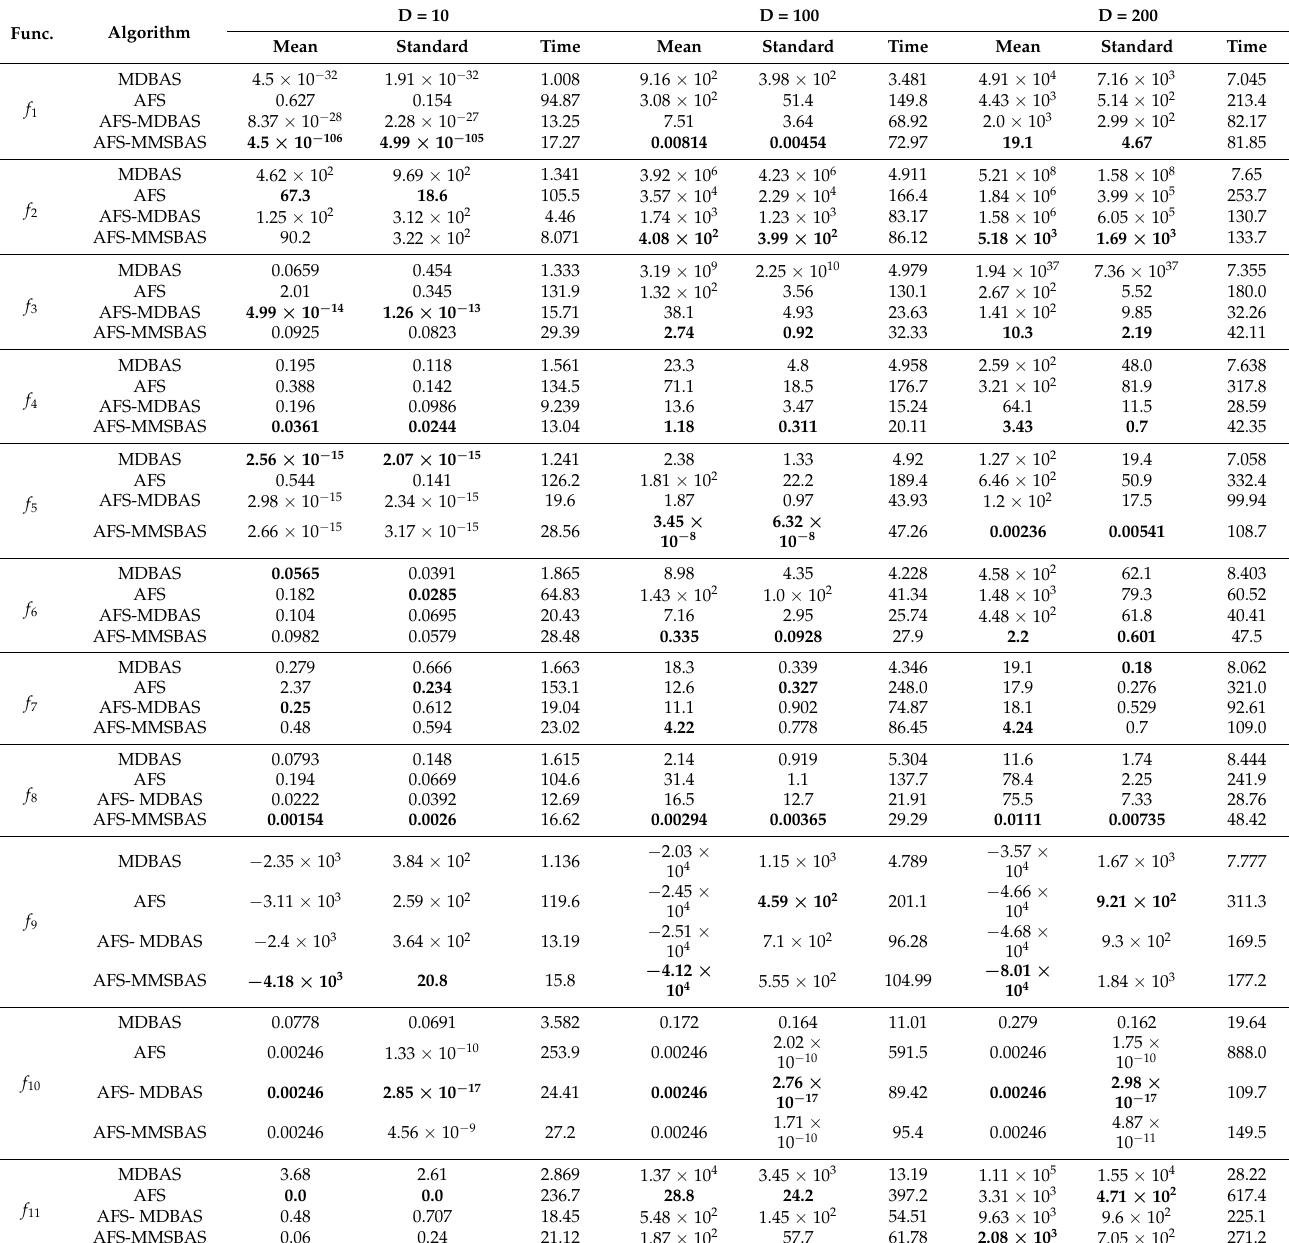
Table 5. Comparisons of four algorithms regarding the optimization of test functions f 1 ~ f 11